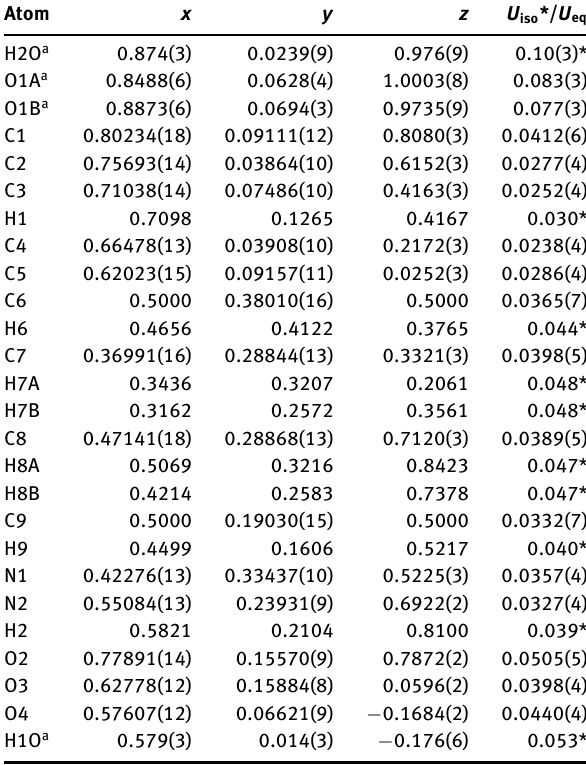
Table 2: Fractional atomic coordinates and isotropic or equivalent isotropic displacement parameters (Å 2